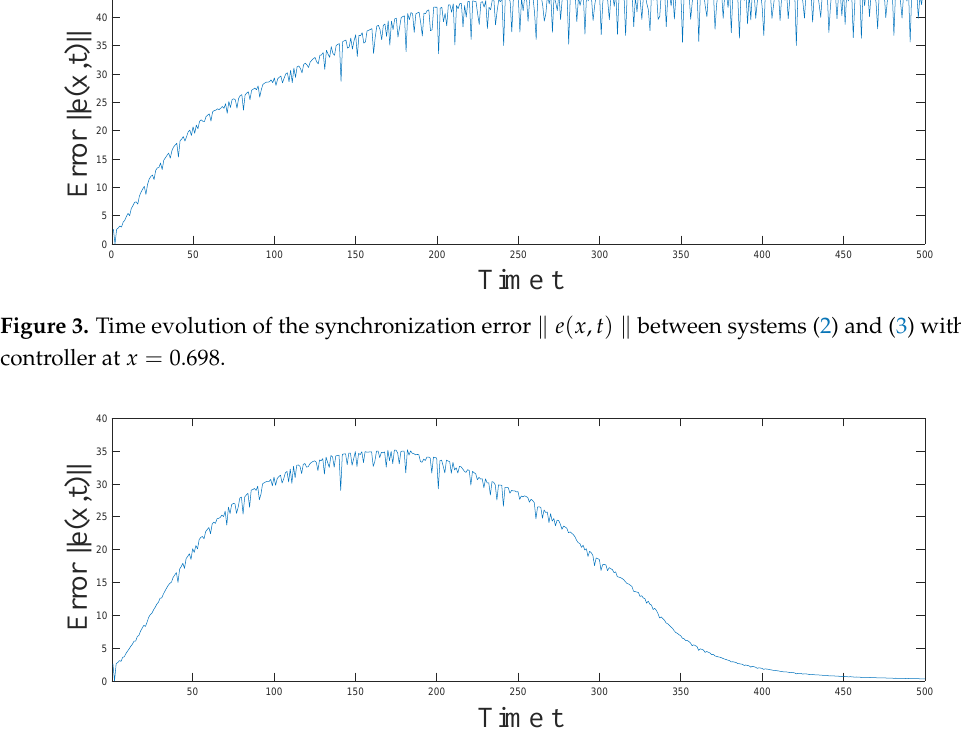
Figure 4. Time evolution of the synchronization error (cid:107) e ( x , t ) (cid:107) between systems (2) and (3) with controller (36) at x = 0.698.